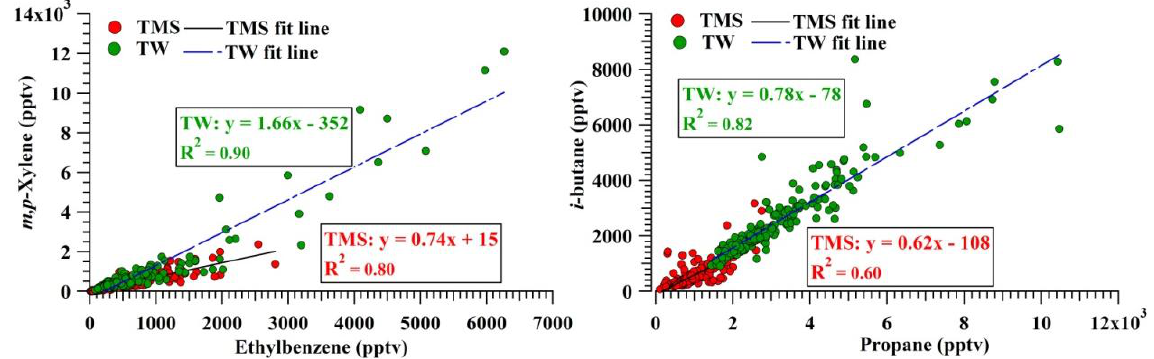
Fig. 4. The scatter plots of (a) m, p -xylenes vs. ethylbenzene and (b) i -butane vs. propane at TMS and TW.